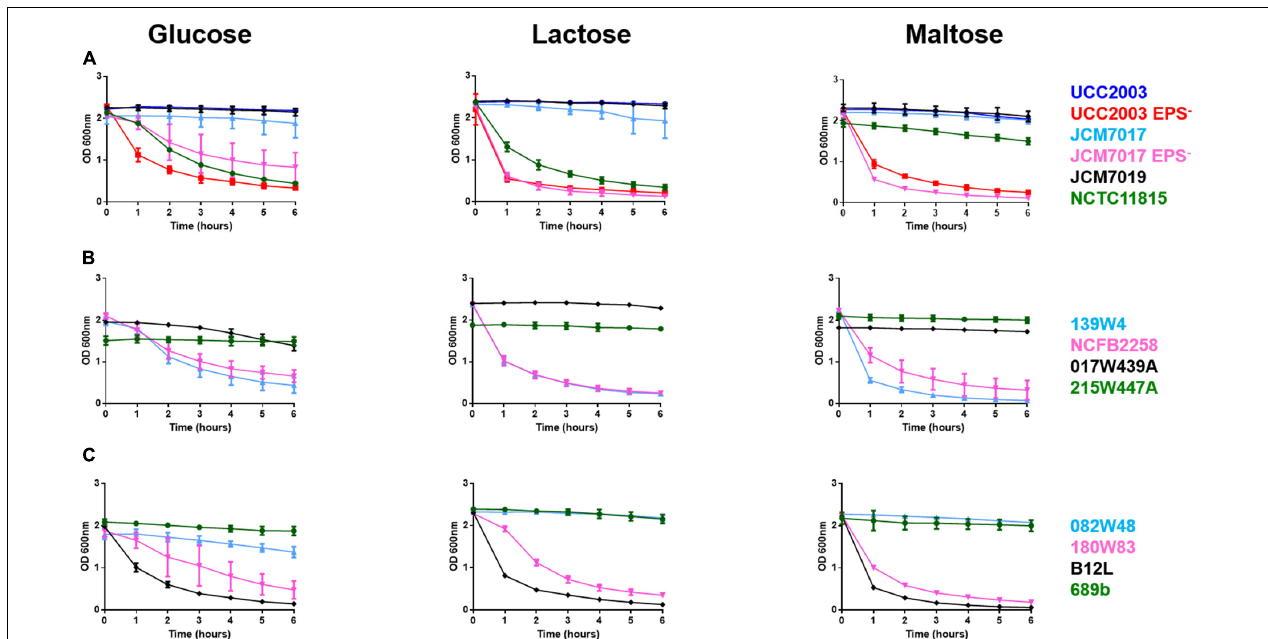
FIGURE 1 | Heterogeneity of EPS production by B. breve strains in different carbon sources. B. breve strains were cultured overnight, homogenized before OD readings were taken from cultures over 6 h with no disturbance to cultures at all. Bacteria were grown in media containing either glucose, lactose, or maltose as a carbon source. This was done for B. breve UCC2003, UCC2003 EPS − , JCM7017, JCM7017 EPS − , JCM7019 and NCTC 11815 (A) , 139W4, NCFB 2258, 215W447A and 017W439A (B) , 082W48, 180W83, B12L and 689b (C) . Data show the average of three independent experiments.